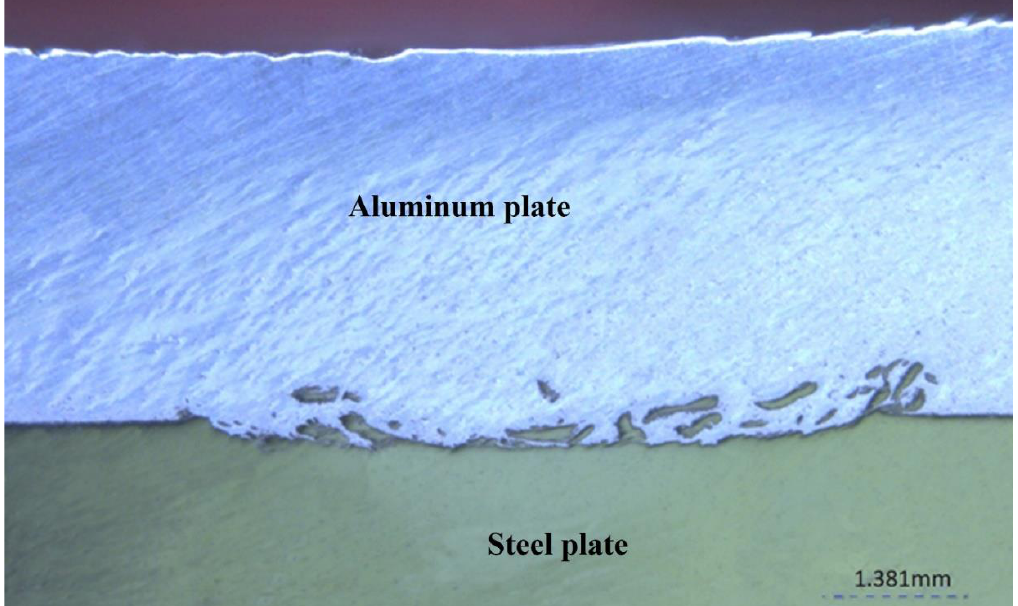
Figure 3. Macrograph of the aluminum/steel interface produced with a medium FSP rotation speed of 1000 rpm and a pin length of 3 mm.